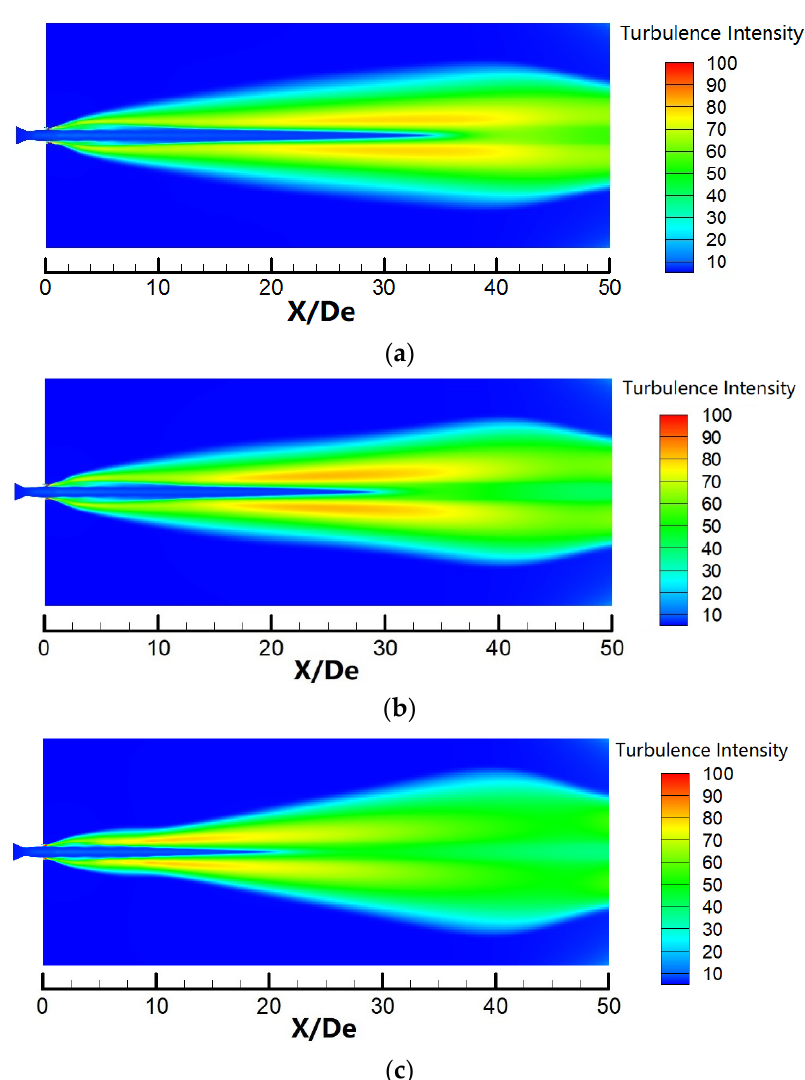
Figure 12. Turbulence intensity contours for three jets: ( a ) methane: nitrogen ratio (RMN) = 10:0, ( b ) RMN = 8:2, and ( c ) RMN = 4:6.